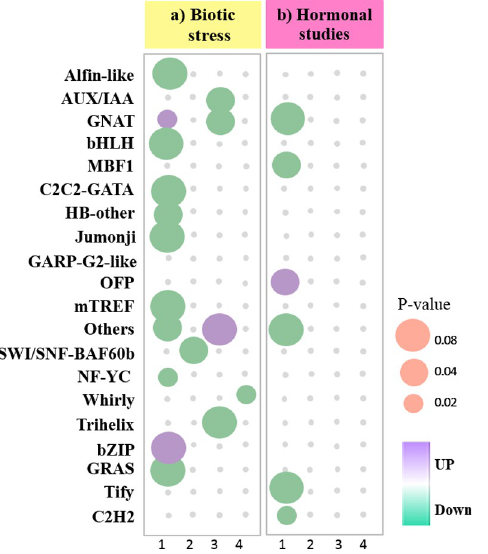
Fig 7. TF families identified in DEGs. (a) The number of up- and down-regulated biotic TF families. (b) The number of up- and down-regulated hormonal TF families. The Y-axis refers to the number of genes. The X-axis shows TF families.